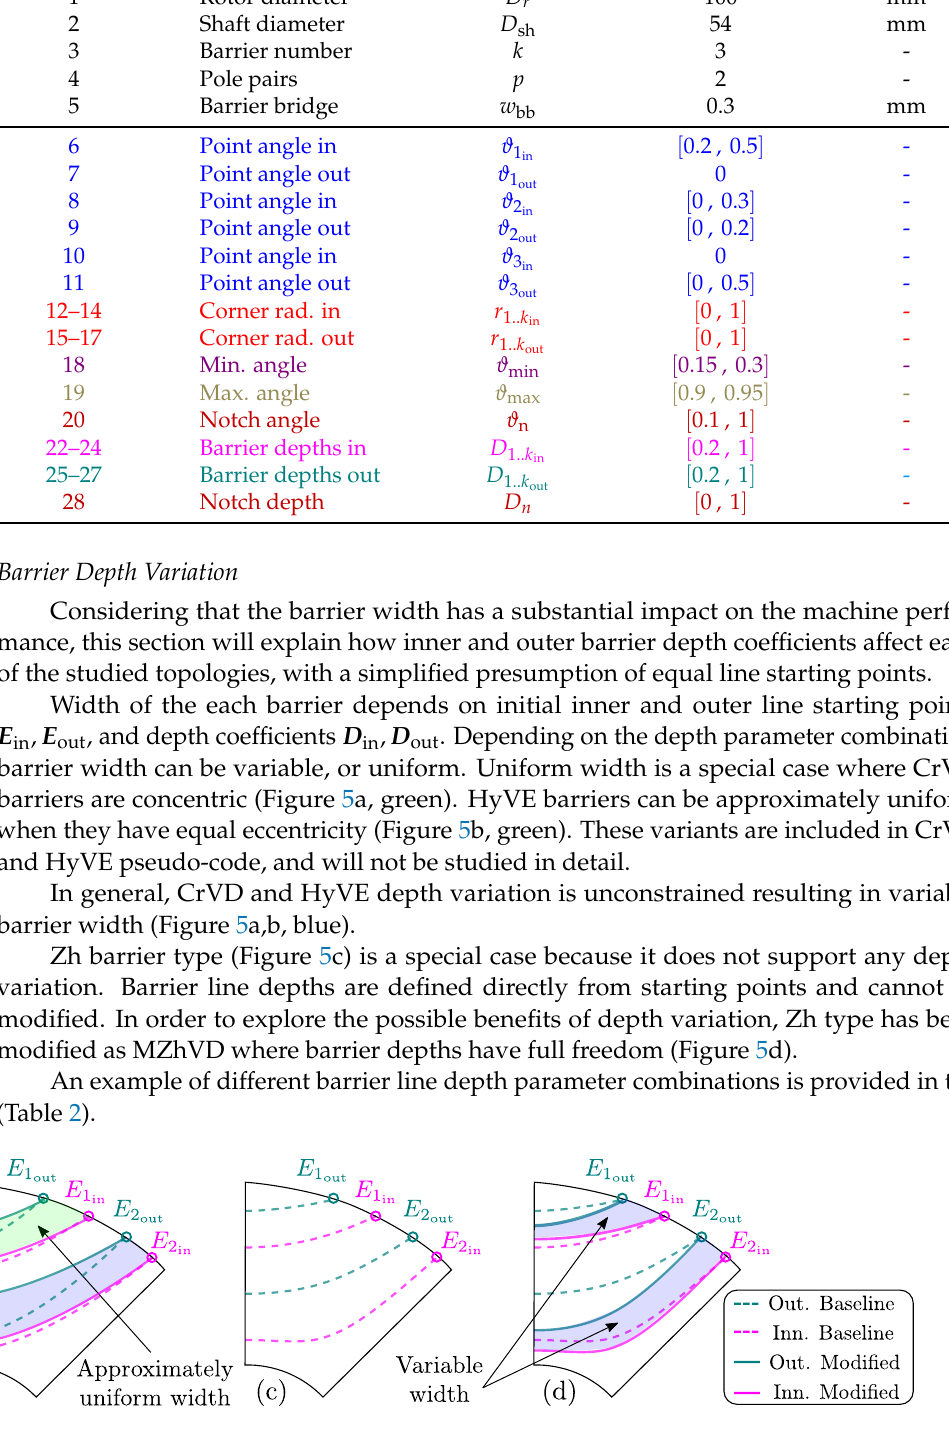
Figure 5. Barrier depth variation influence on different 2-barrier ( k = 2) SyRM topologies. Circular ( a ); Hyperbolic ( b ), Zhukovsky ( c ) and Modified Zhukovsky barrier types ( d